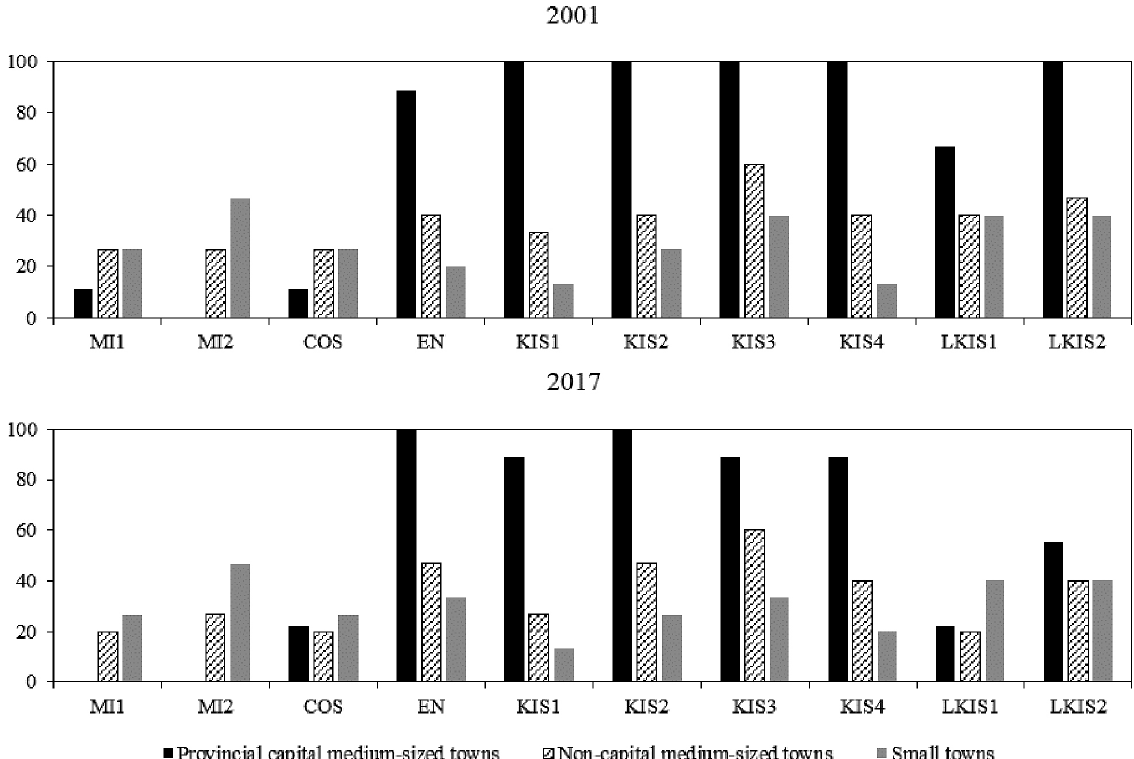
Fig. 3. Specialisation of the centres (LQ>1) in 10 industries broken down by level of technological and knowledge intensity (2001, 2017), percentage value.